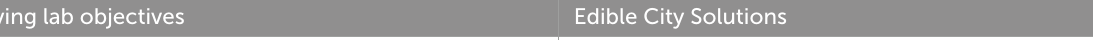
TABLE 1 Objectives and implemented or planned ( ∗ ) Edible City Solutions (ECS) of the Living Labs [for detailed information on the Living Labs see (Plassnig et al., 2022)]. Living lab objectives Edible City